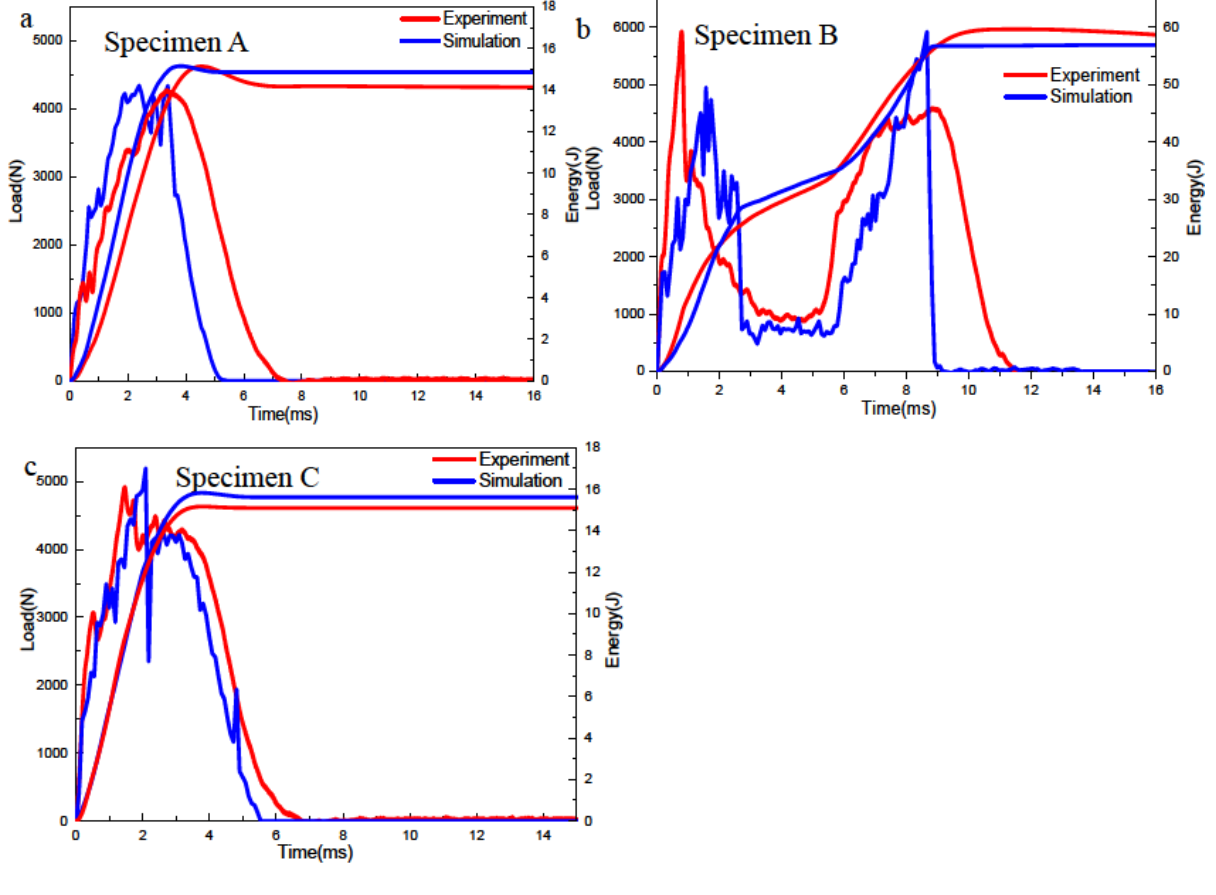
Figure 6: Response of specimens impacted under the impact energy of 15